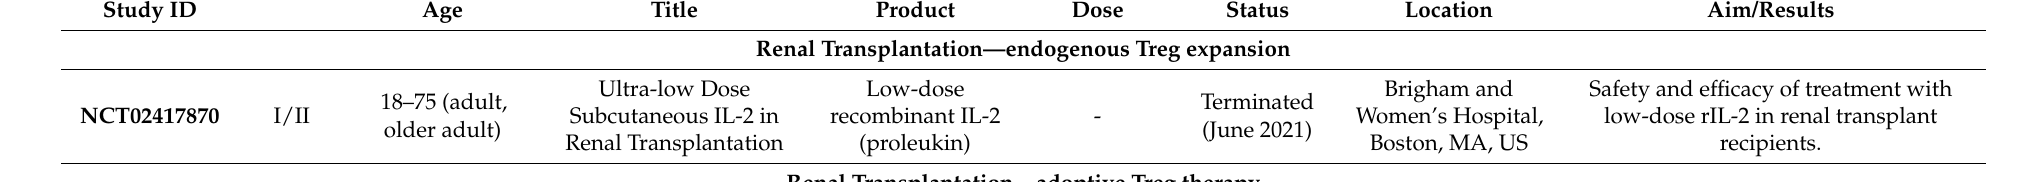
Table 1. Ongoing clinical trials adopting regulatory T-cell therapy in solid organ transplantation (search date 26 September